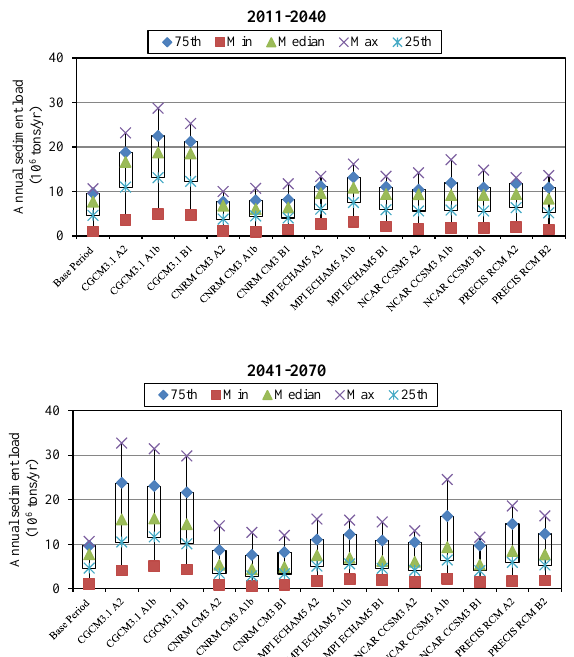
Fig. 14. Box and whisker plots of annual sediment load at gaug- ing stations of Nam Ou for present climate (1971–2000) and for all climate projections. Results are for the 2011–2040 and 2041–2070 time periods.